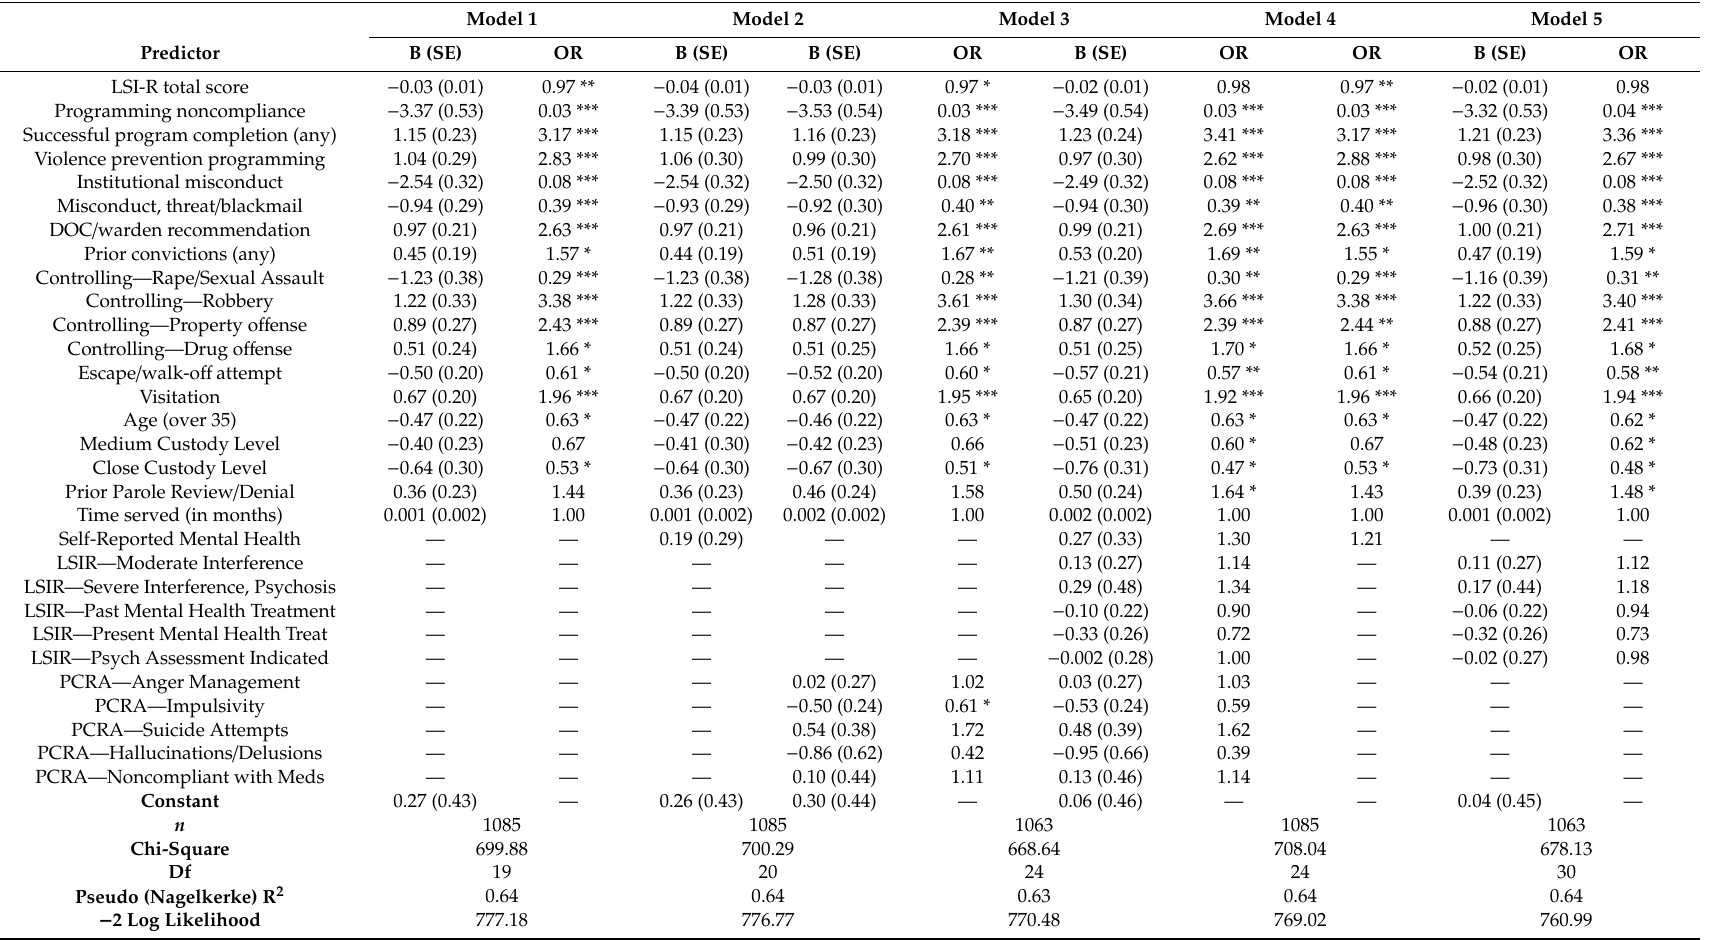
Table 3. Multiple logistic regression models predicting parole decisions: control variables, and self-reported, Level of Service Inventory-Revised (LSI-R), and Post-Conviction Risk Assessment (PCRA) mental health